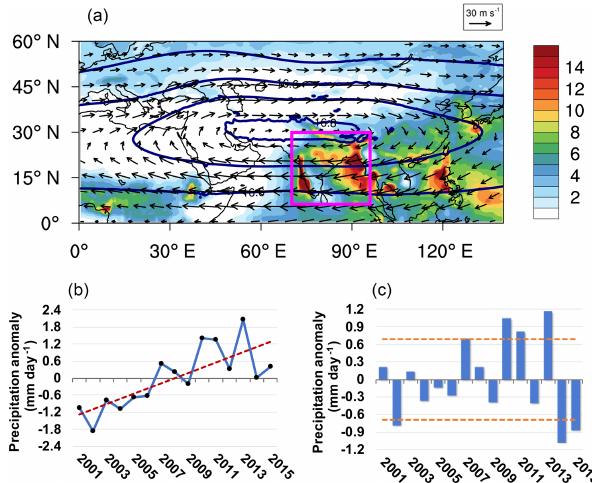
Figure 1. Climatological mean ASM features associated with the AMA showing (a) the spatial distribution of winds (arrows, in ms − 1 ), geopotential height at 100hPa (solid contours, in km) and rainfall (colored background, in mmday − 1 ) during July–August of 2001–2015. The pink box (5–30 ◦ N, 70 ◦ N–95 ◦ E) outlines the do- main selected for calculating the precipitation intensity. (b) Time series of the precipitation anomaly from 2001 to 2015 (with the trend line in red). (c) The detrended distribution (with standard de- viations in